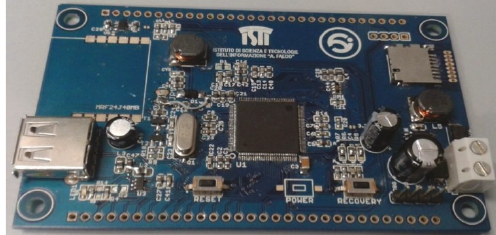
Figure 7: Actual vision